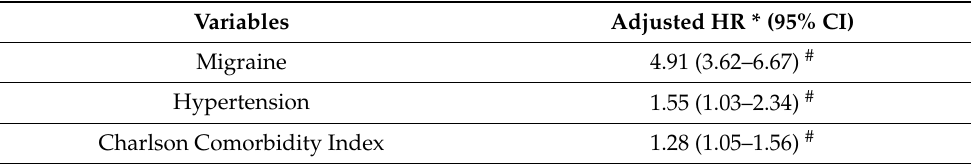
Table 3. Significant predictors of trigeminal neuralgia after